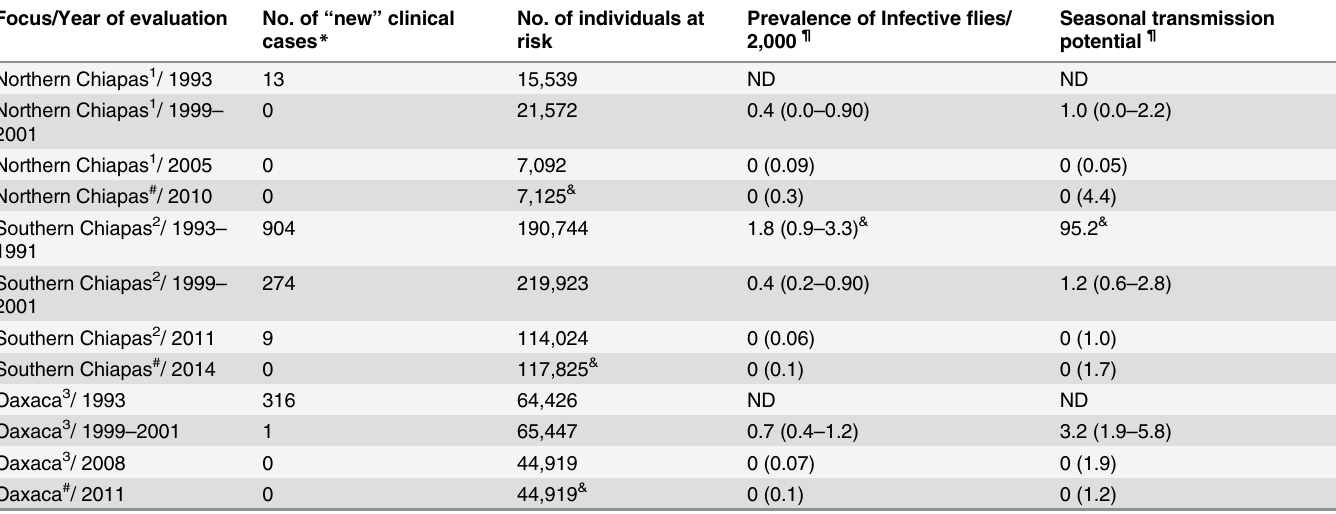
Table 1. The epidemiological situation in the three onchocerciasis endemic foci in